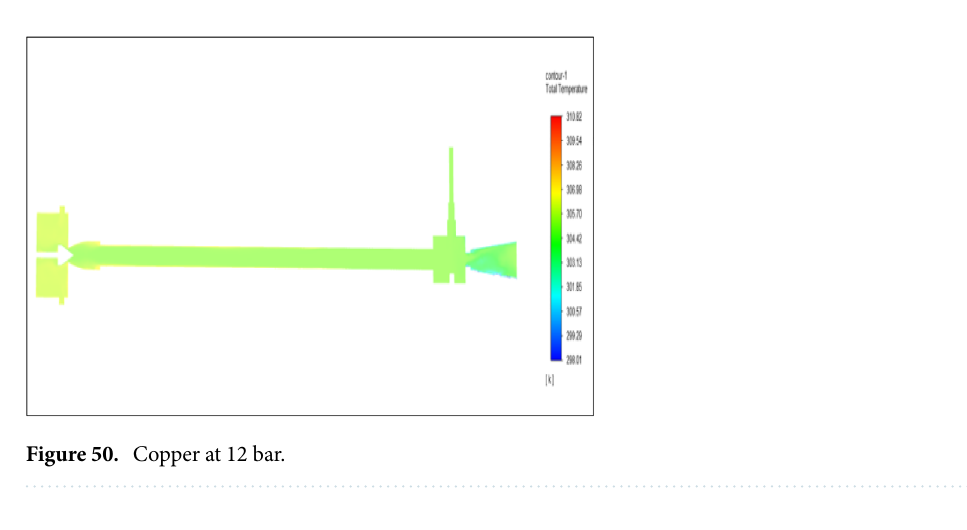
Figure 49. Bronze at 12 bar.